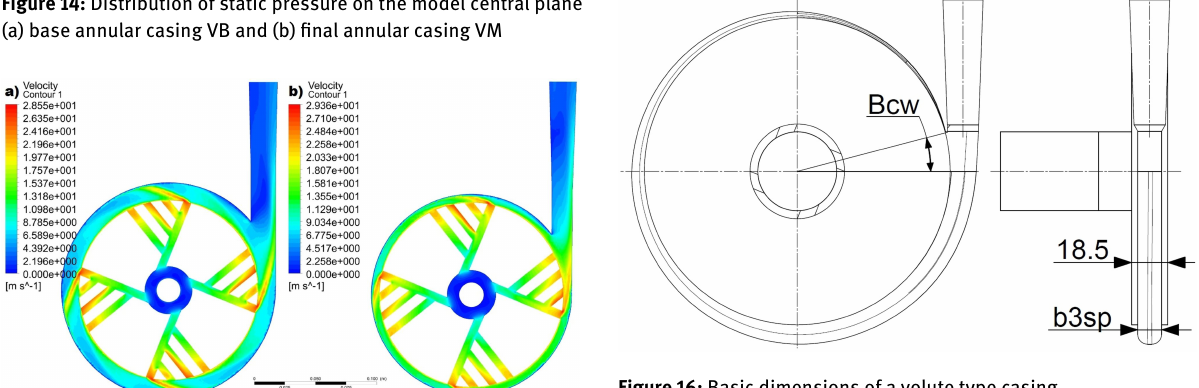
Figure 16: Basic dimensions of a volute type